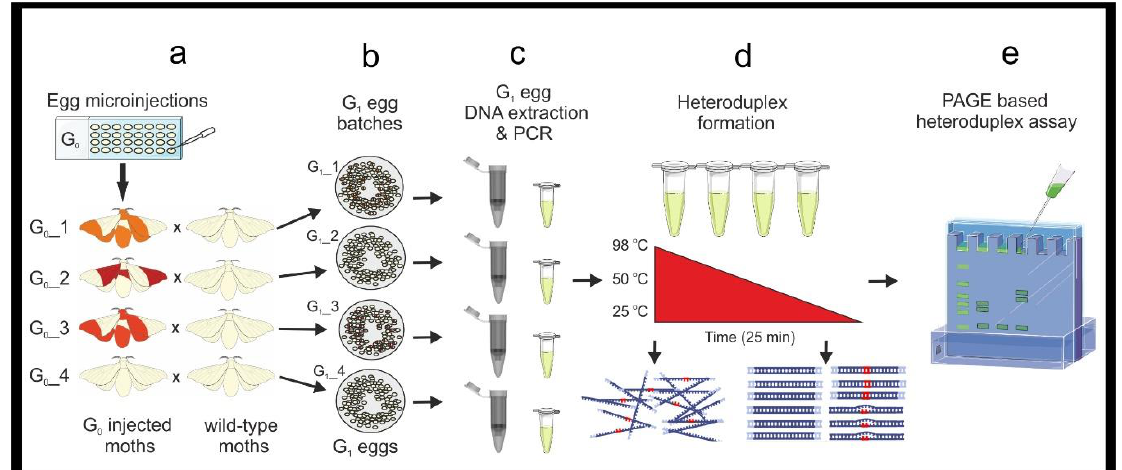
Figure 1. The targeted B. mori per region for mutagenesis. Lower- and upper-case letters identify introns and exons, respectively. Primers amplifying the 485 bp per fragment are in yellow. Underlined black signifies the gRNA, the PAM site is indicated with blue italics.